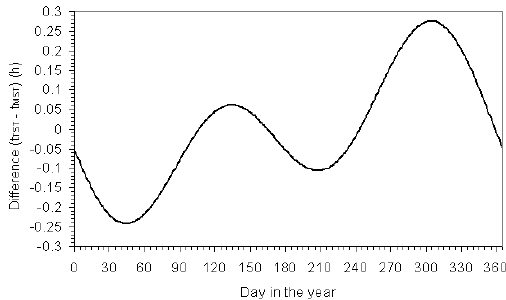
Figure 6. Difference between the true solar time ( t TST ) and the mean solar time ( t MST ); excerpt from Wald (2007).